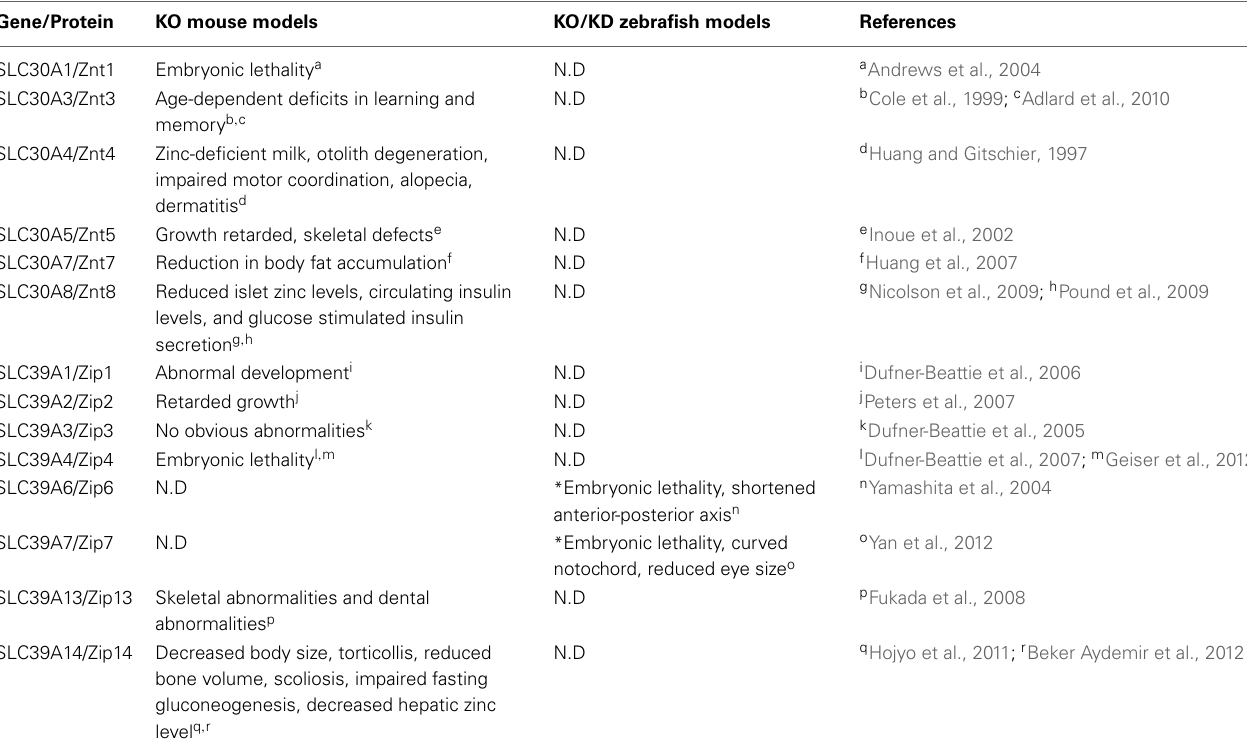
Table 4 | Zinc metabolism–related mouse and zebrafish knockout/knockdown models and their phenotypes.